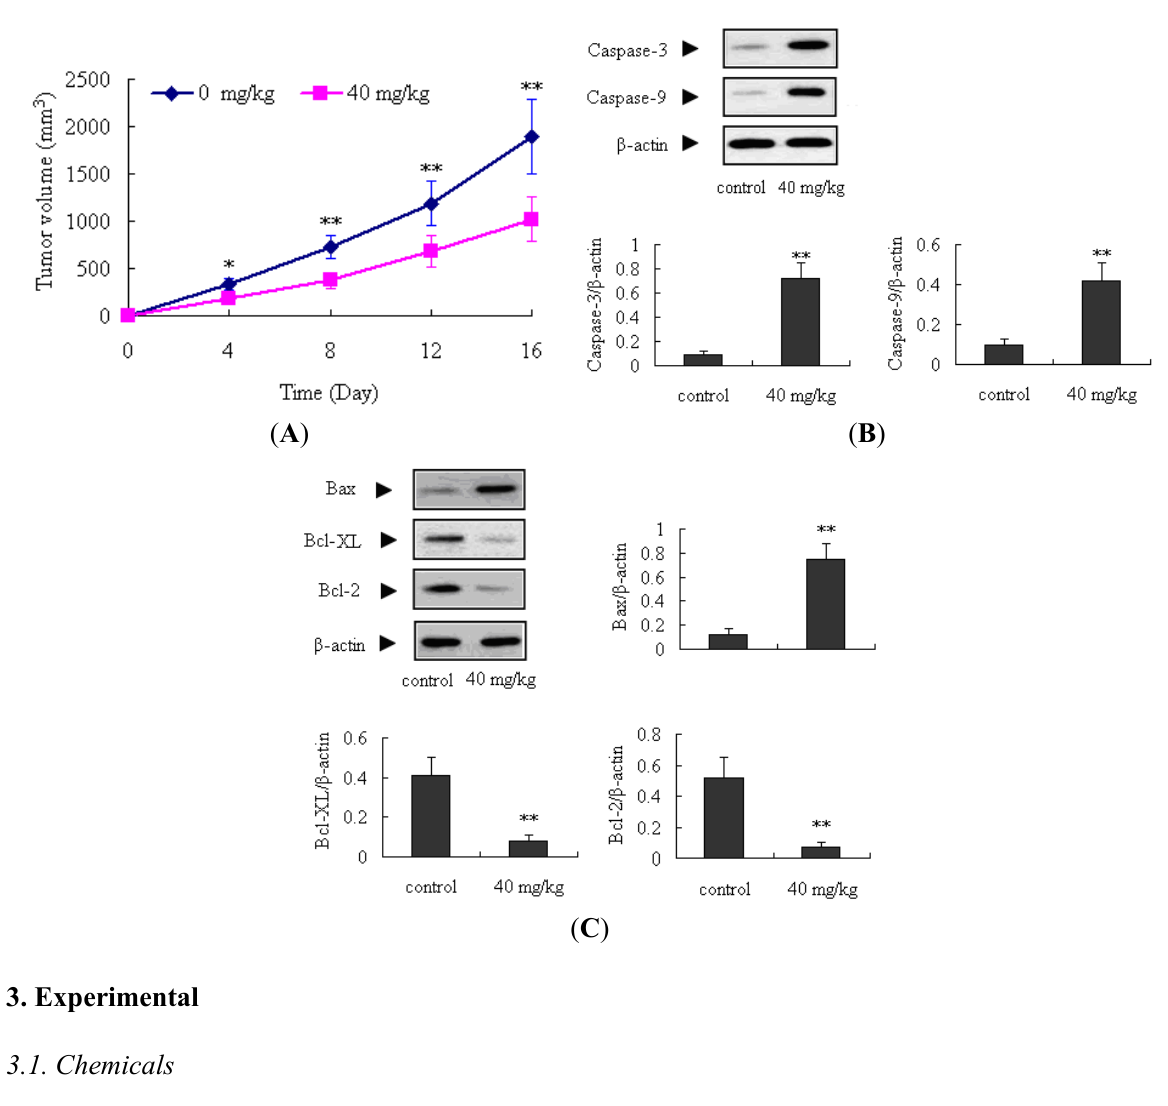
Figure 8. Antitumor activity of ATL-I in A549 cells in vivo . ( A ) The effect of ATL-1 on tumor volume in 16 days observation (n = 10). ( B ) Expressions of caspase-3 and caspase-9 in the tumor tissues (n = 3). ( C ) Expressions of Bax, Bcl-2 and Bcl-XL in the tumor tissues (n = 3). All data were expressed as mean ± SEM, * p < 0.05, ** p < 0.01, vs.